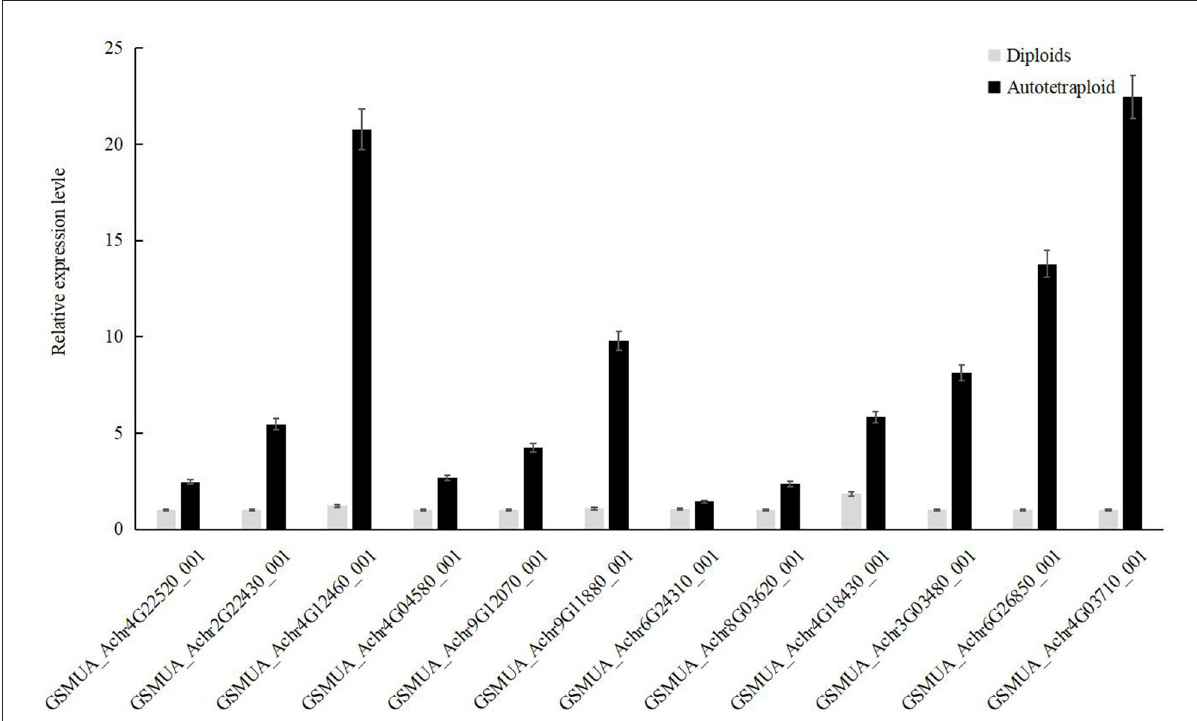
FIGURE7 Quantitative RT-PCR results of up-regulated genes in autotetraploid of Pisang Berlin.